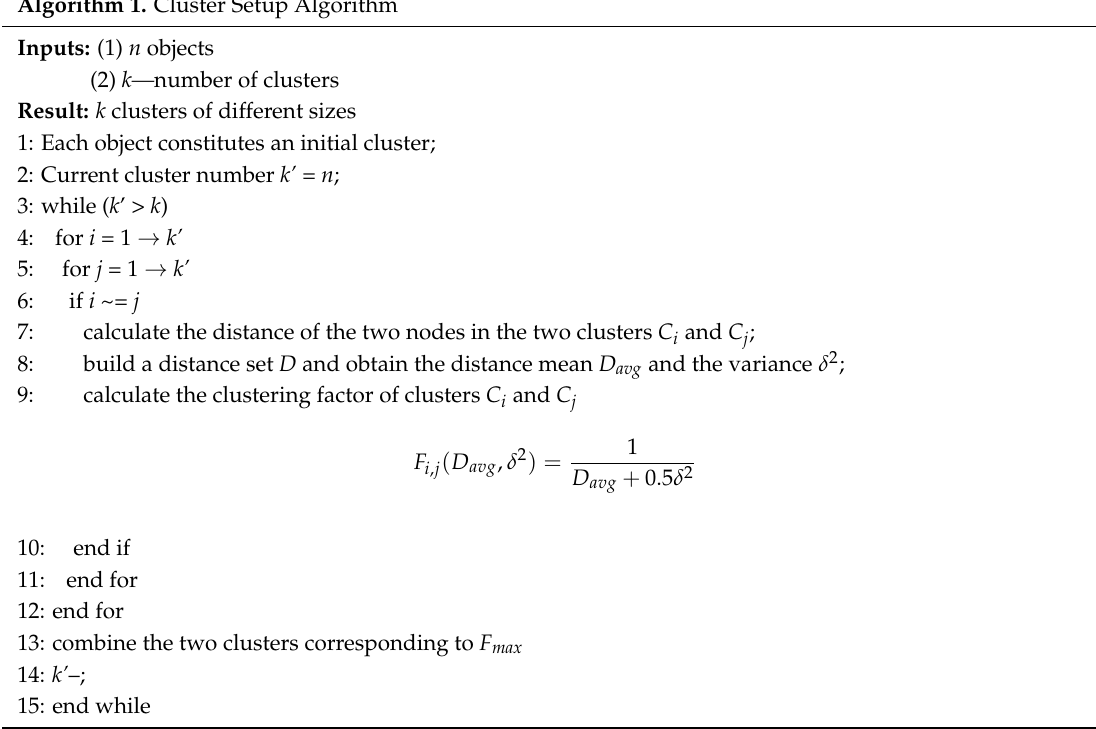
Algorithm 1. Cluster Setup